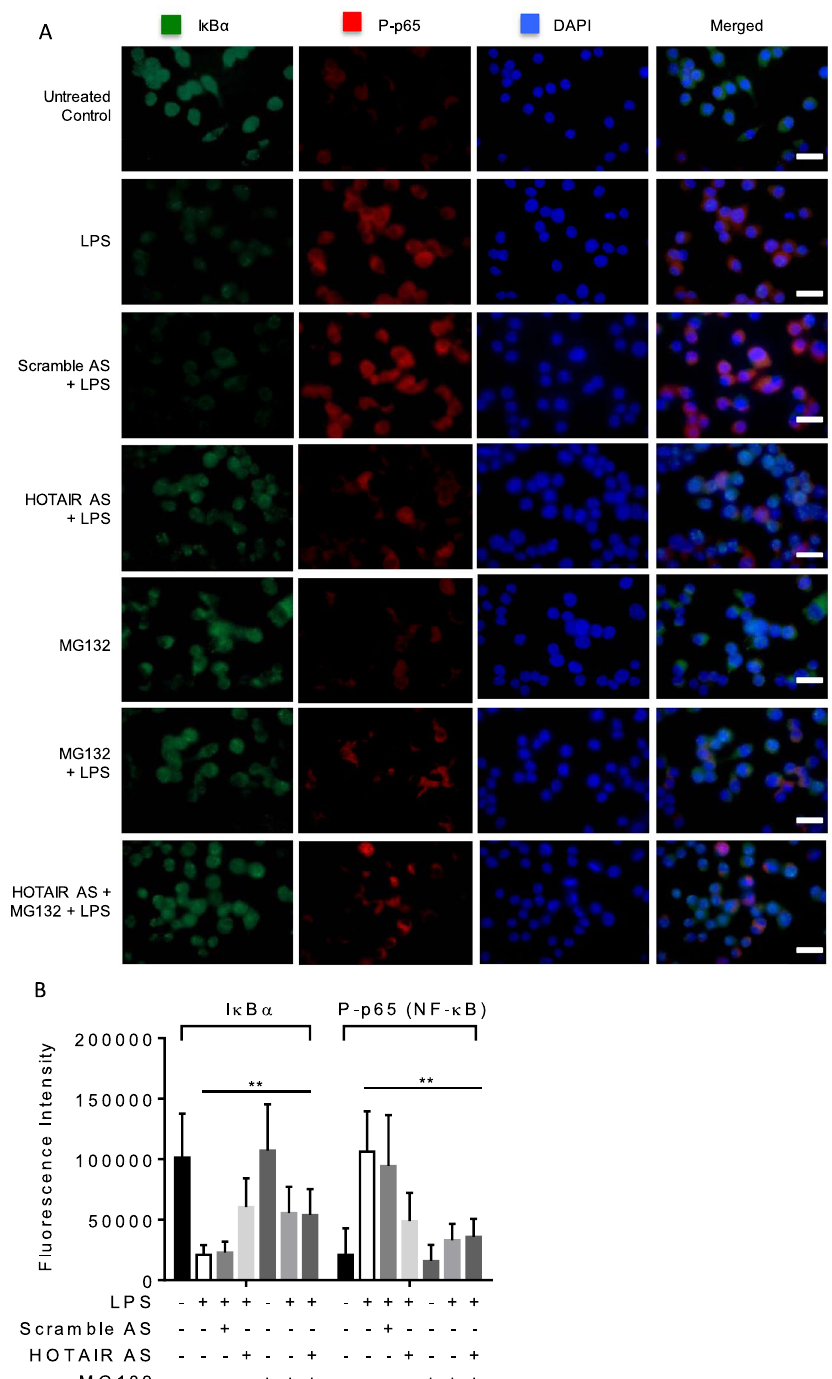
Figure 5. HOTAIR promotes I κ B α degradation and nuclear translocation of NF- κ B. HOTAIR was silenced in RAW 264.7 cells by using HOTAIR antisense and scramble (control) for 48 h. Additionally, cells were also treated with proteasomal inhibitor MG132 (2 h) alone or in combination with HOTAIR-knockdown and then treated with LPS (1 h). The cells were then fixed with paraformaldehyde and immunostained with antibody against I κ B α and phospho NF- κ B (P-p65), and counterstained with DAPI. Images were taken by fluorescence microscope (Nikon ECLIPSE TE2000-U) ( A ) and fluorescence intensity showing the expressions of I κ B α and phospho-p65 was quantified and plotted by ImageJ software ( B ). Data represent mean ± SD; * p < 0.05, ** p <